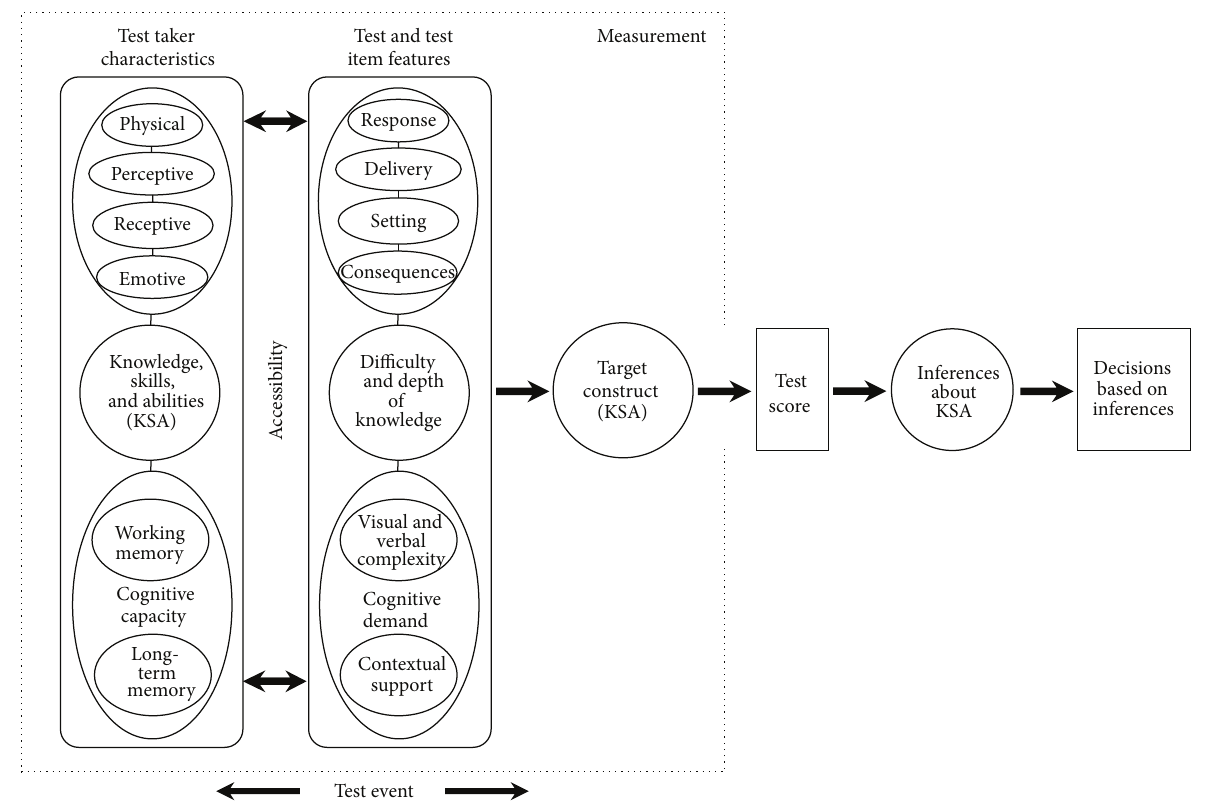
Figure 1: Accessibility theory ([4], used with